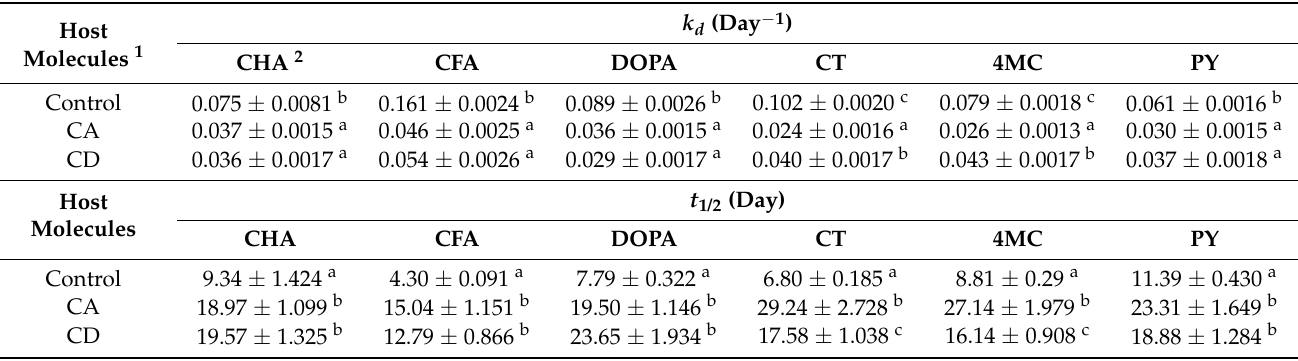
Table 1. Estimated degradation rate constants (k d ) and half-life ( t 1/2 ) of DPPH radical scavenging activity for PCs in the absence and presence of CA and